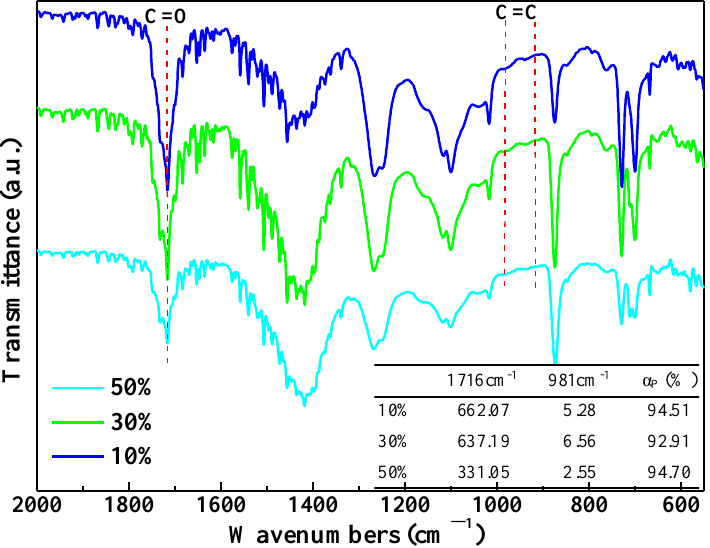
Figure 8. FTIR spectra and C=C conversion rate of the UPR composites under 800 W microwave for 30 s.